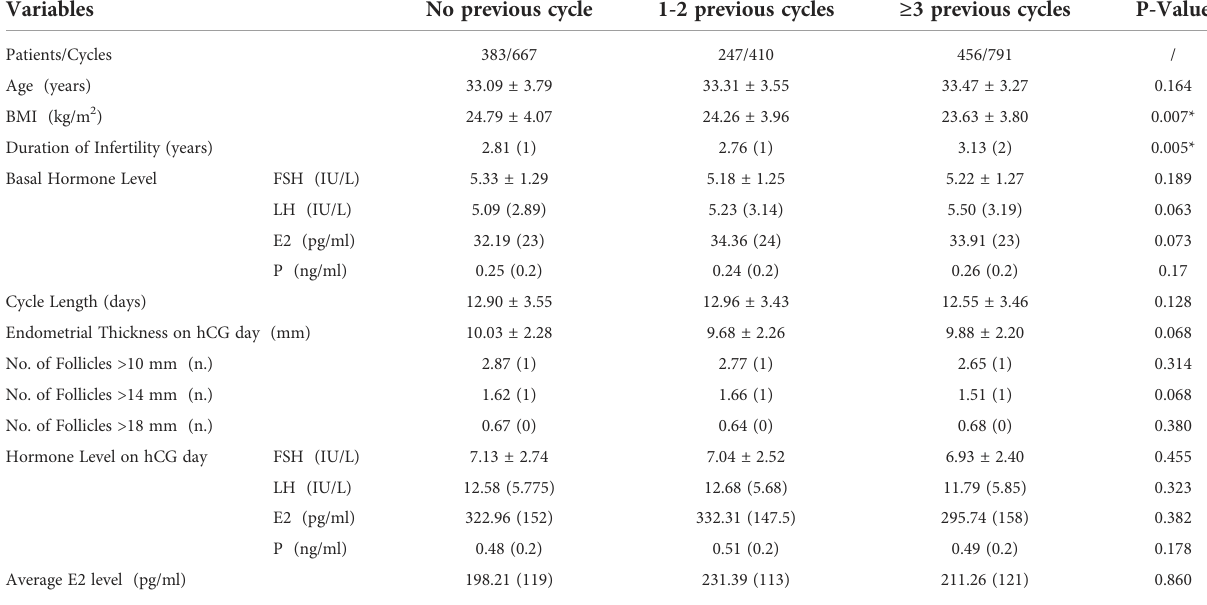
TABLE 2 Comparison of baseline and cycle